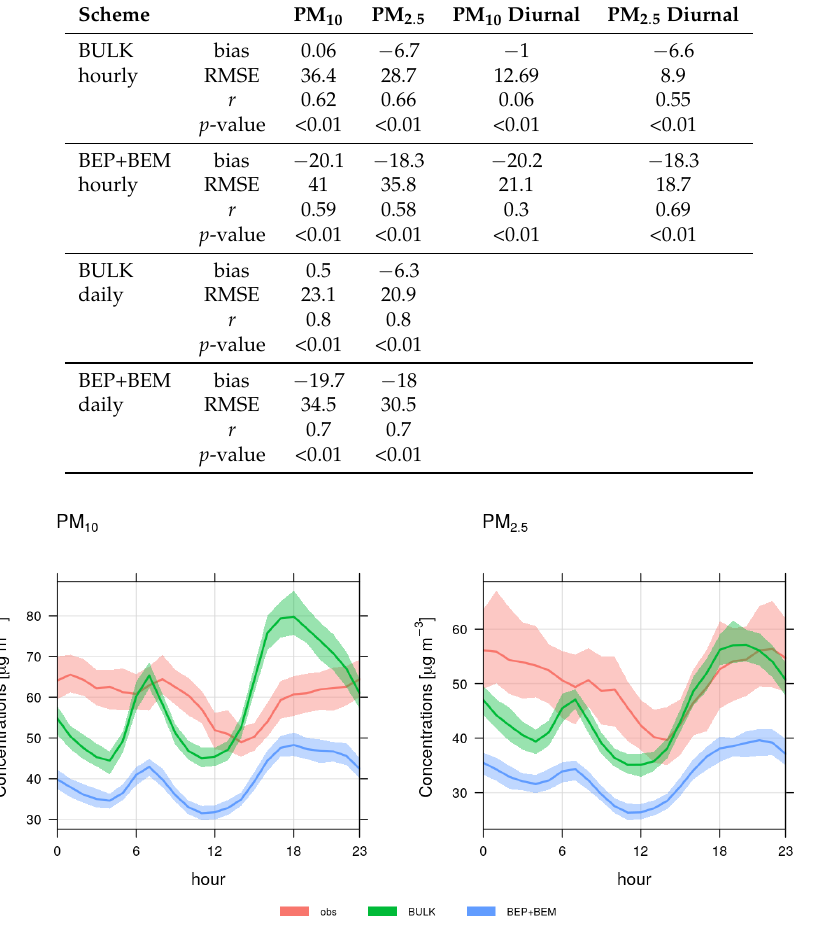
Figure 6. Averaged diurnal profiles of PM 10 and PM 2.5 concentrations for observations (red), BULK simulations (green), and BEP+BEM simulations (blue). Lines represent the mean values and shaded areas the 95% confidence interval in the